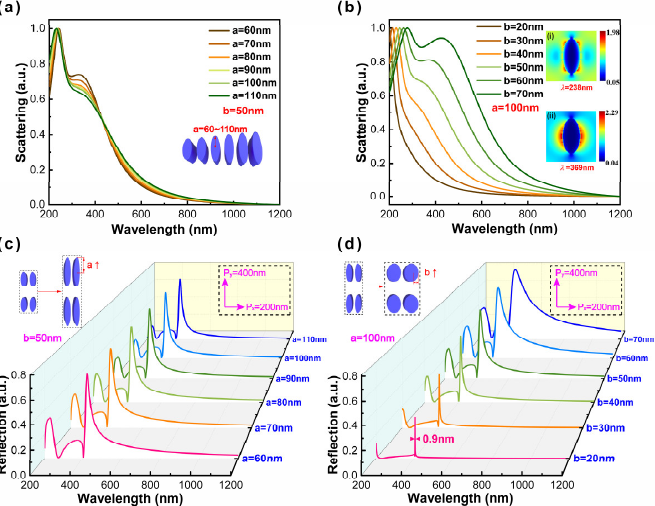
Figure 2. The far-field scattering spectra of individual nanoparticles with varied ( a ) semi-major axis parameters from 60 nm to 110 nm and ( b ) semi-minor axis parameters from 20 nm to 70 nm (at 10 nm intervals); the insets represent the near-field distribution corresponding to the wavelengths of 238 nm and 369 nm. The reflectance spectra of periodic arrays with varied ( c ) semi-major axis parameters from 60 nm to 110 nm and ( d ) semi-minor axis parameters from 20 nm to 70 nm (at 10 nm intervals). (The small window shows the schematic illustration of varied structural parameters of individual nanoparticles and periodic